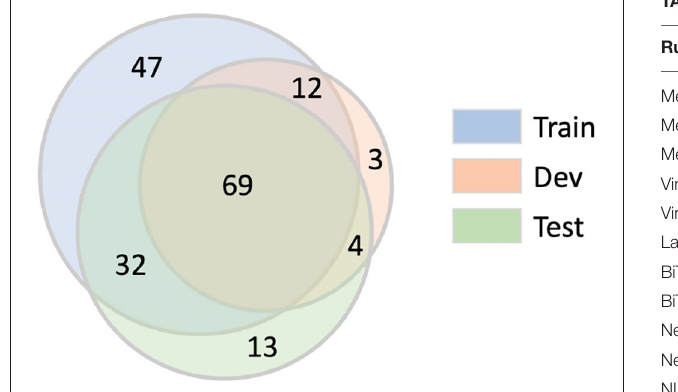
TABLE 13 | F 1 scores on